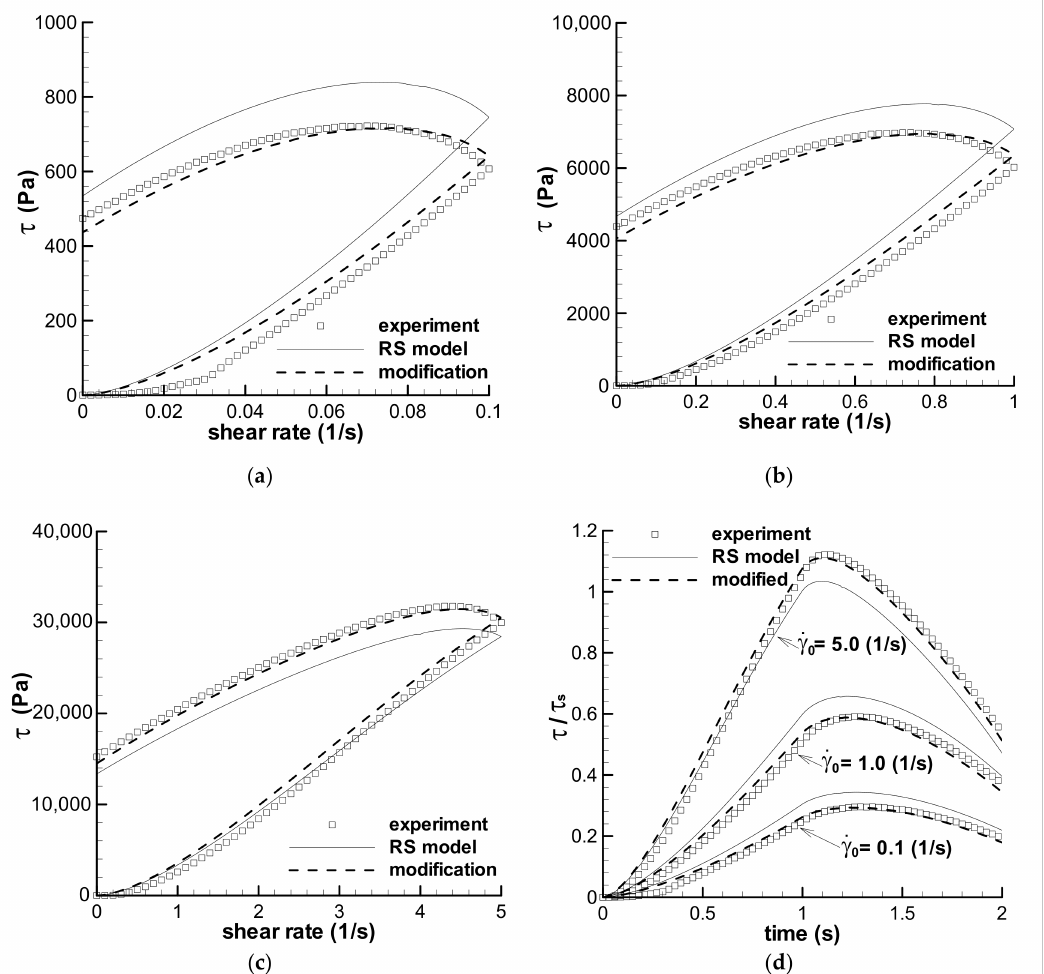
Figure 5. Predictions of the triangular-loop experiments with the same characteristic time t 0 of 1.0 s. The stress–shear rate curves with the maximum shear rates of 0.1 s − 1 ( a ), 1 s − 1 ( b ), and 5 s − 1 ( c ) are given. ( d ) Shows the stress–time curves. Symbols are experiments, solid lines are the calculations by the RS model, and dashed lines are the calculations by the modified spectrum with f in Table 4. τ s is the steady shear stress calculated by the RS model at the maximum shear rate.